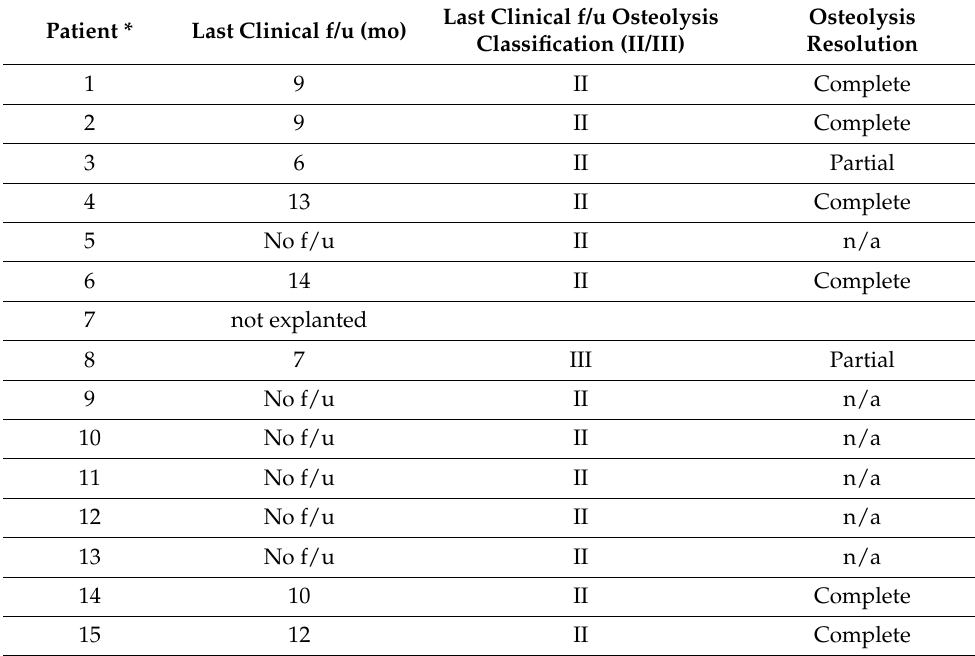
Table 3. Post-Explantation Osteolysis